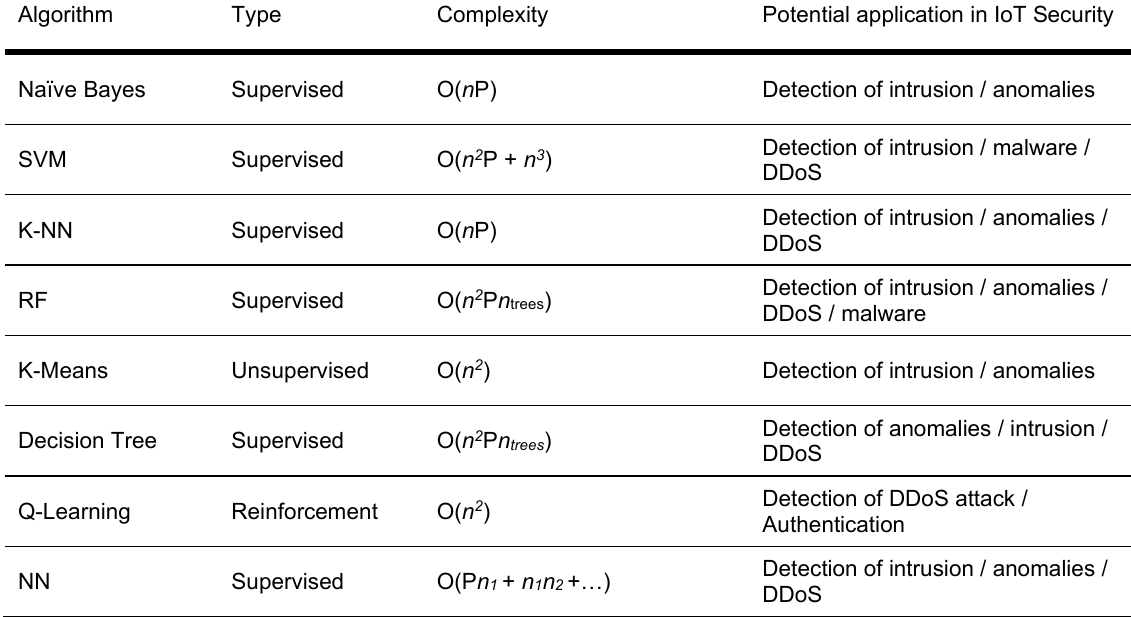
Table 1. Potential ML techniques for IoT